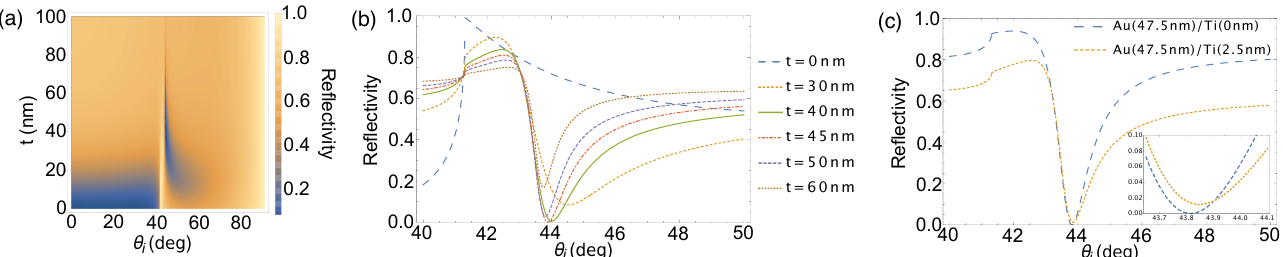
Figure 1b. The presence of the Ti layer shows almost negligible effect to the location of the SPR angle as shown in Figure 1c.